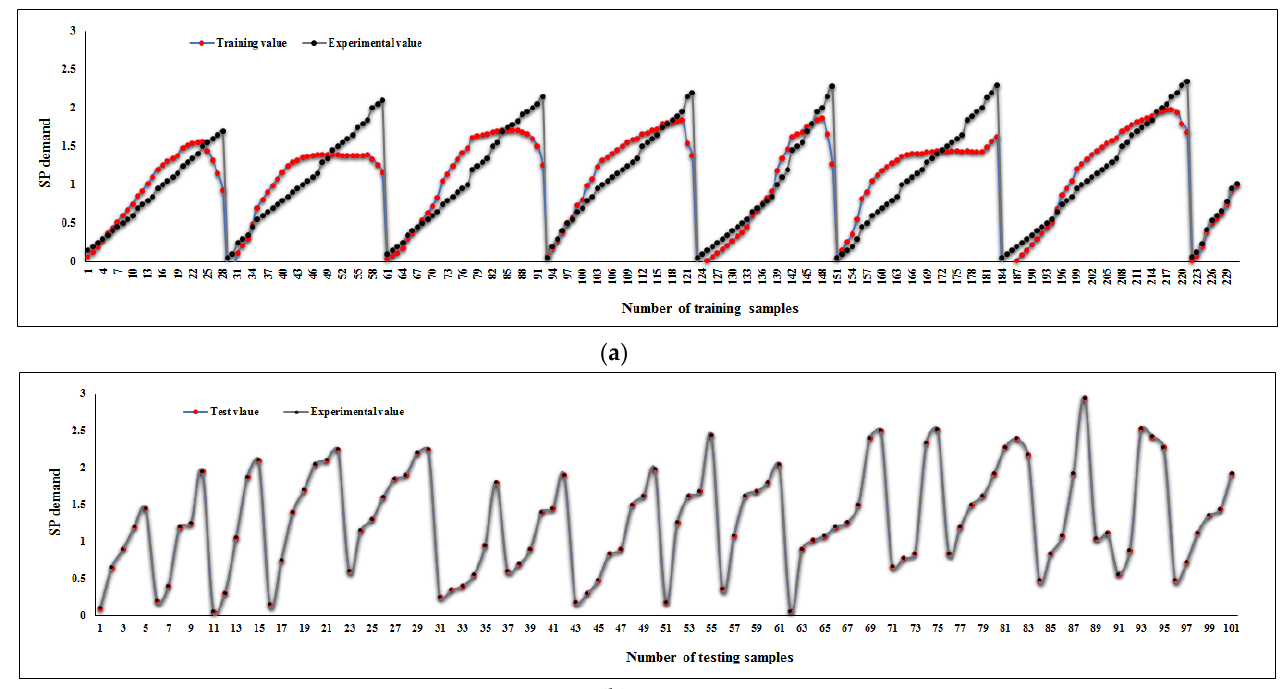
Figure 16. Tolerance diagram of predicted and measured values for ( a ) training phase and ( b ) testing phase.